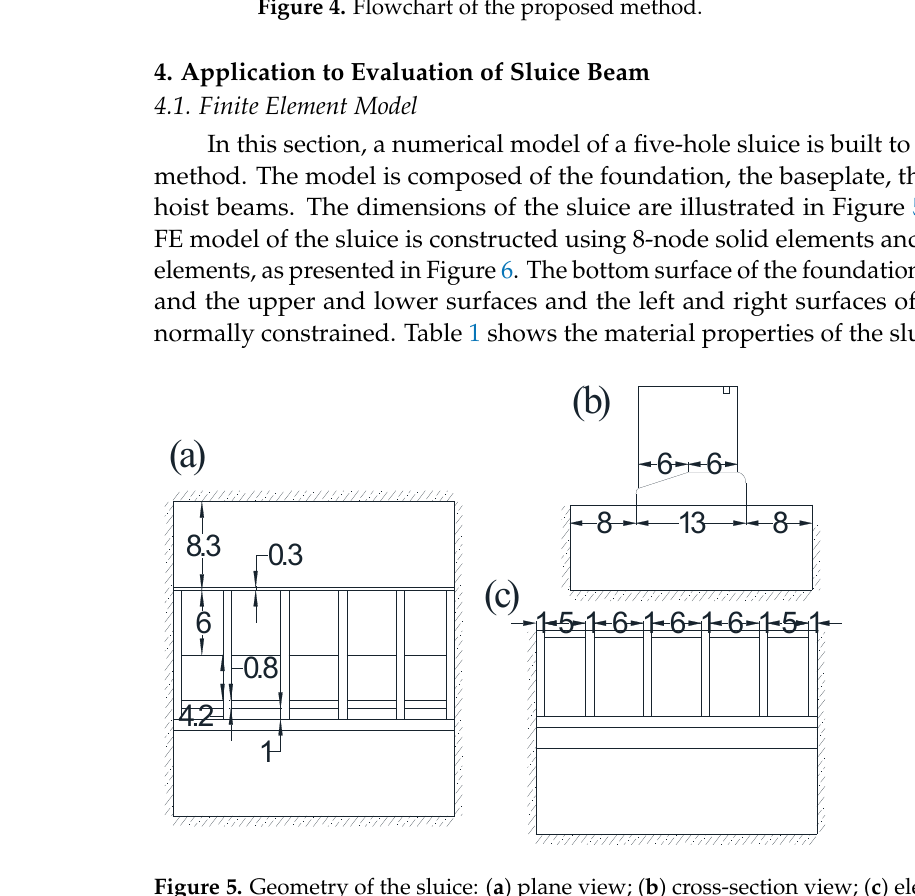
Figure 5. Geometry of the sluice: ( a ) plane view; ( b ) cross-section view; ( c ) elevation view.